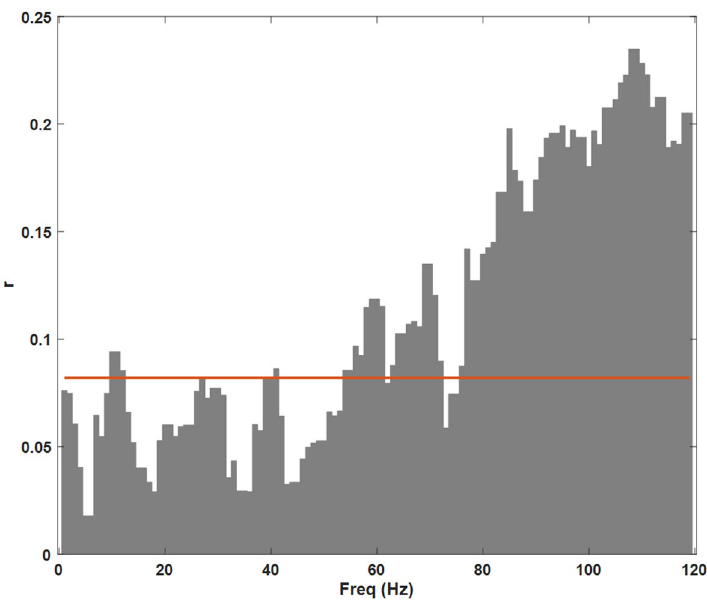
Figure 4. Correlation of pre- and poststimulus activity for each frequency at electrode FCz. The red bar indicated the significance level (Bonferroni corrected). It can be seen that a clear relation of pre- and poststimulus activity is nearly restricted to the gamma band